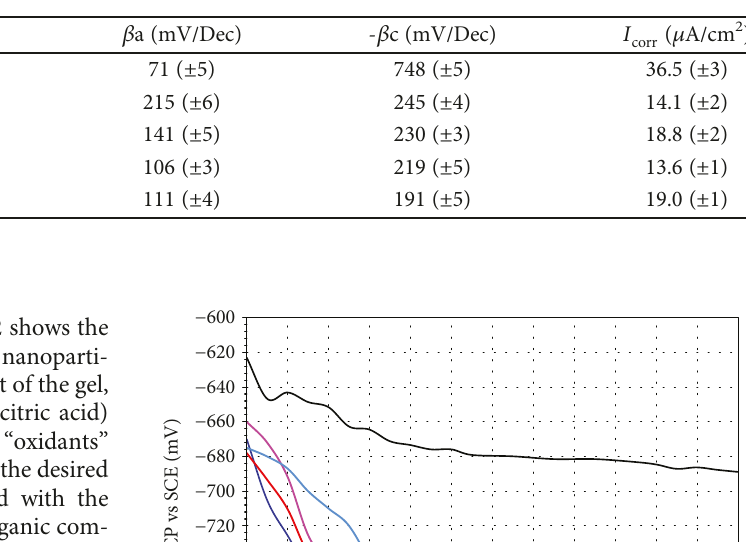
Table 1: Electrochemical parameters from polarization curves.